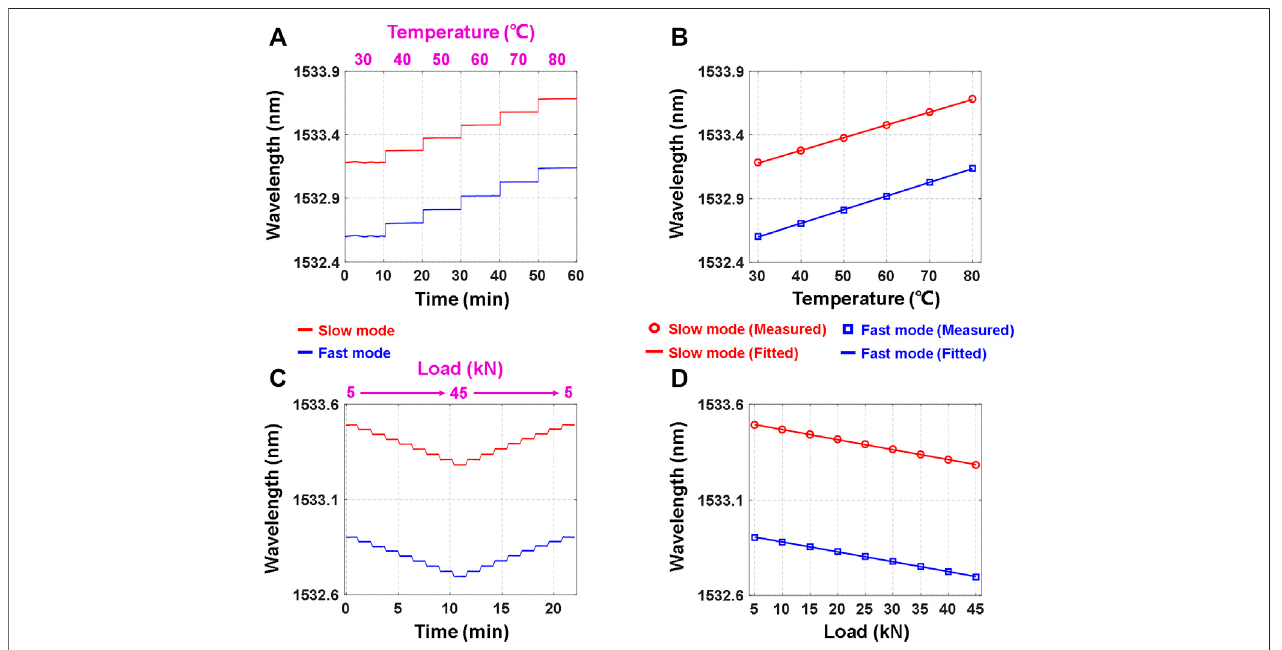
FIGURE 3 | Real-time responses to (A) temperature and (C) force changes corresponding to the two sensing modes. Bragg wavelengths of the two sensing modes as a function of the (B) temperature and (D) force.